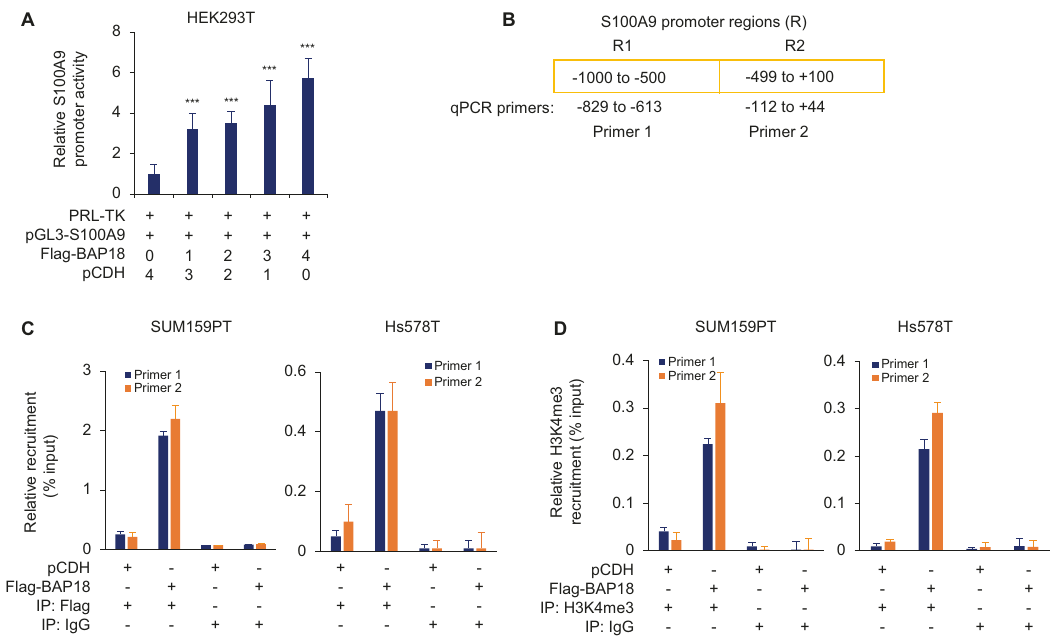
Fig. 6 BAP18 is recruited to S100A9 promoter and enhances its promoter activity. A HEK293T cells were transfected with the pGL3-S100A9 luciferase reporter plasmid alone or in combination with increasing doses of Flag-BAP18. pRL-TK reporter plasmid was also transfected into HEK293T cells as an internal control for transfection ef fi ciency. After 48 h of transfection, cells were lysed and luciferase activities in triplicate samples were determined. Luciferase values (relative light units) were calculated and normalized to controls. Values are reported as the fold- increase and represent the mean ± SD from three independent transfection experiments. B Line diagram showing the regions of S100A9 promoter analyzed. C ChIP analysis for the recruitment of BAP18 onto the S100A9 promoter in SUM159PT and Hs578T cells stably expressing pCDH and Flag-BAP18. D ChIP analysis for the recruitment of H3K4me3 onto the S100A9 promoter in SUM159PT and Hs578T cells stably expressing pCDH and Flag-BAP18. *** p < 0.001. Cell Death and Disease (2022)